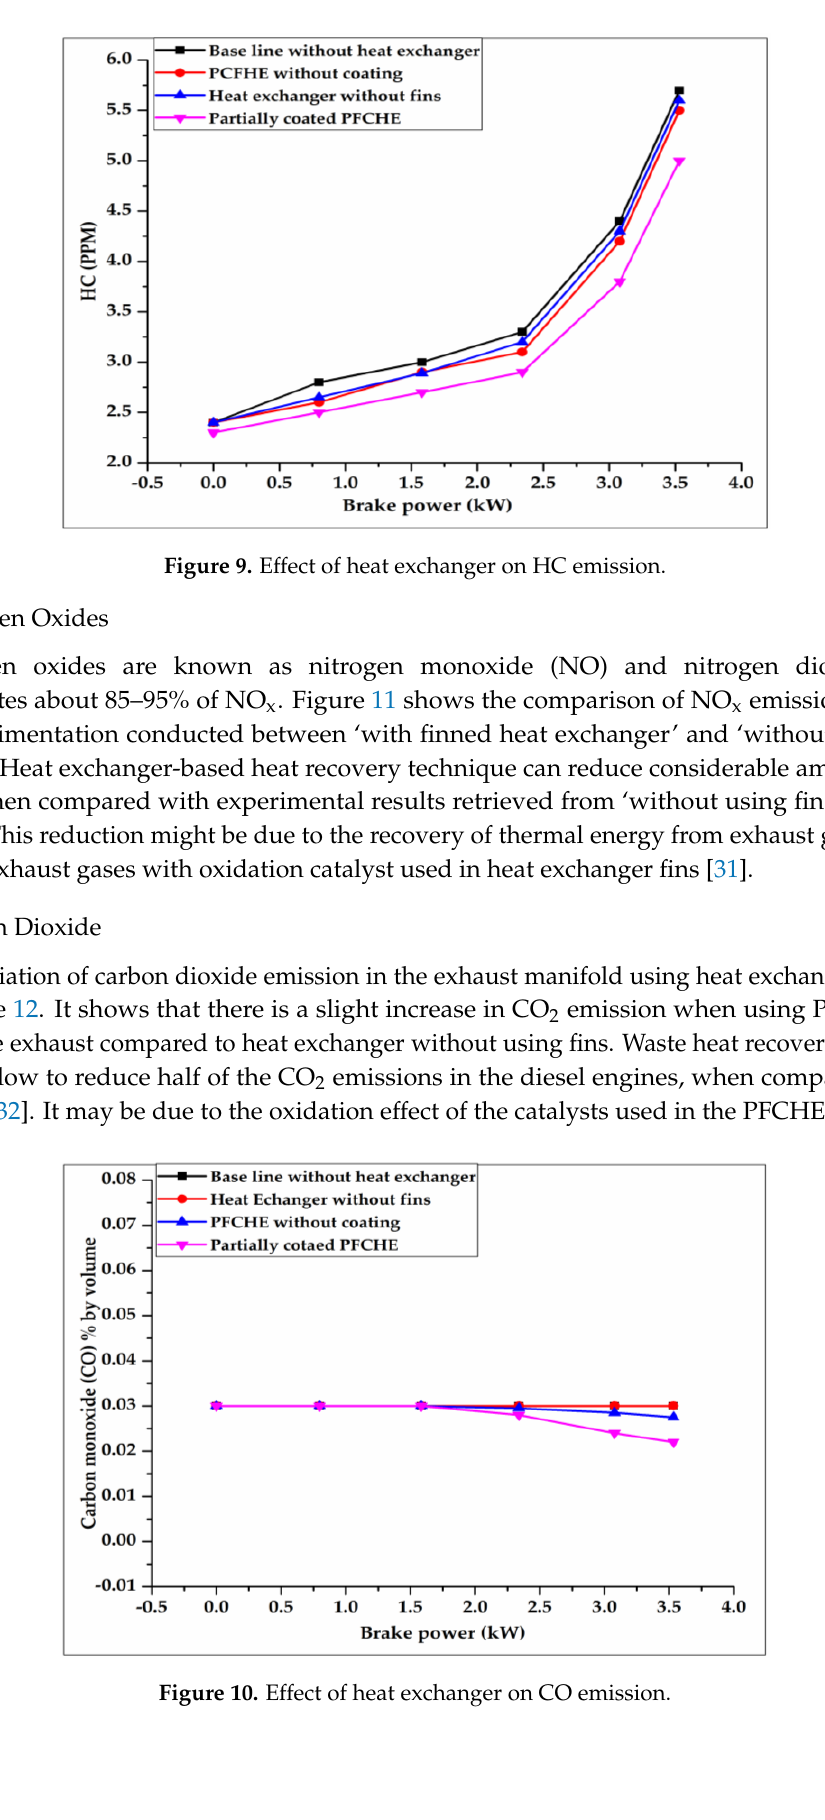
Figure 11. Effect of heat exchanger on NO x emission. 4.6.5. Smoke Intensity The comparative results of smoke intensity is indicated as Hatridge Smoke Units (HSU)and is shown in Figure 13. Variation of smoke emissions is relatively less at low power operations due to a smaller amount of fuel particle being present in the burning process. The impact of the implementation of ‘protracted both internally– externally finned counter flow heat exchanger with partial coating’ in waste heat recovery resulted in low smoke emissions when compared with diesel fuel. This is due to the diesel oxidation catalyst used in part of the heat exchanger fins and reactions with exhaust gases. The smoke was formed due to pyrolysis of PAH (Polycyclic Aromatic Hydrocarbons) and it predominated at full load operating conditions [33].